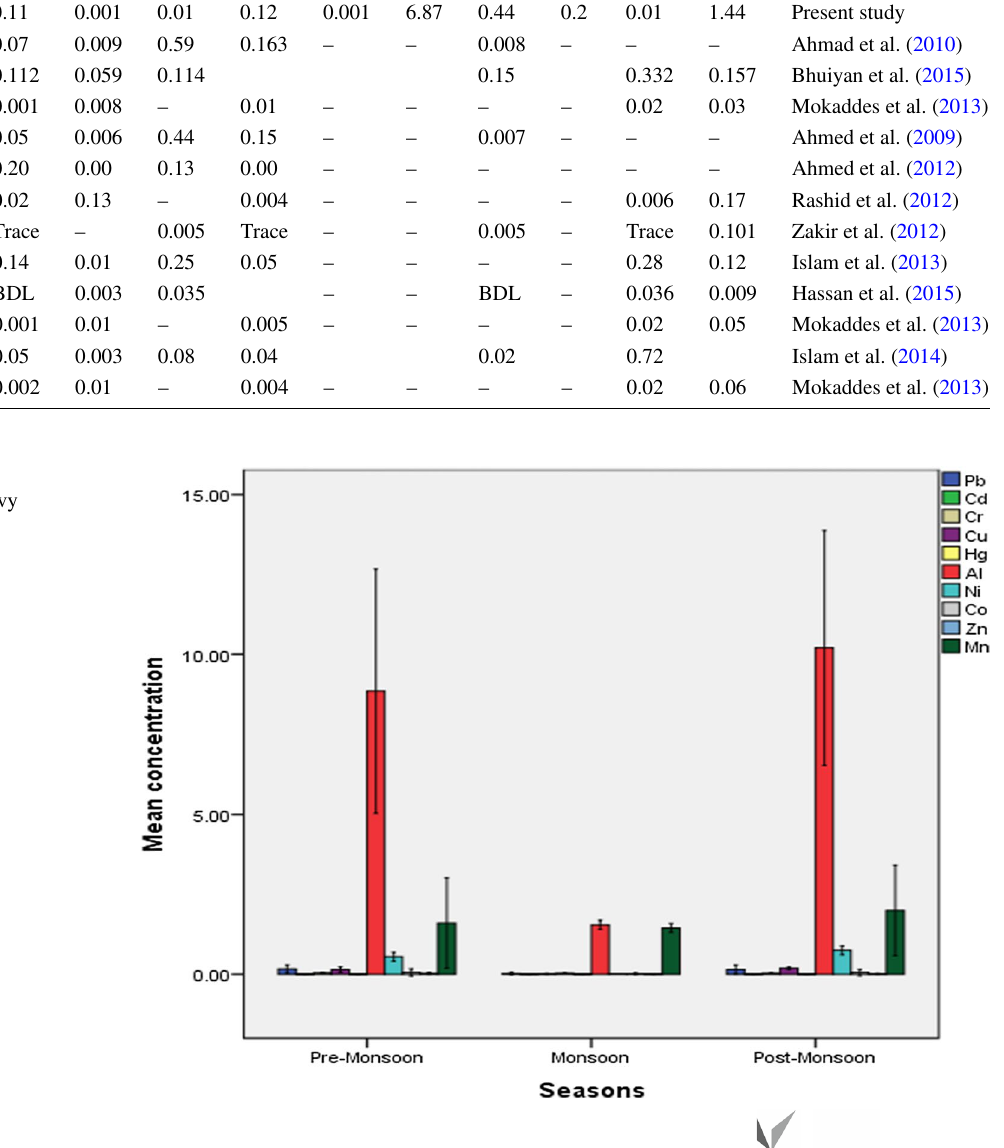
Table 2 Comparison of the observed values of heavy metals in the water of the Old Brahmaputra River with other rivers of Bangladesh River